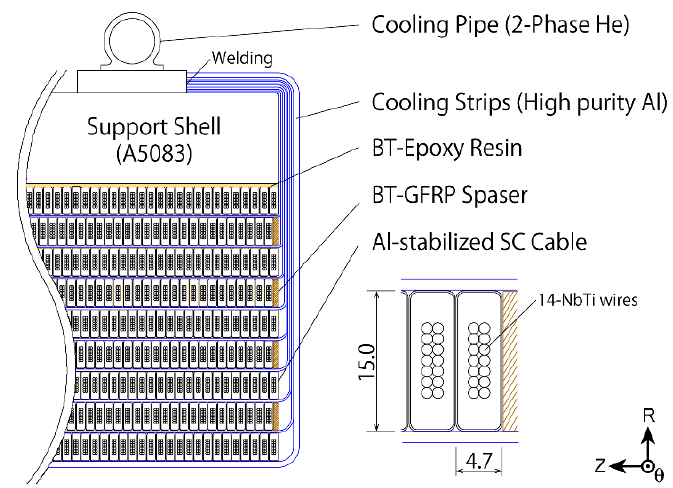
Figure 2. Details of thermal design of the capture solenoid coil (CS).